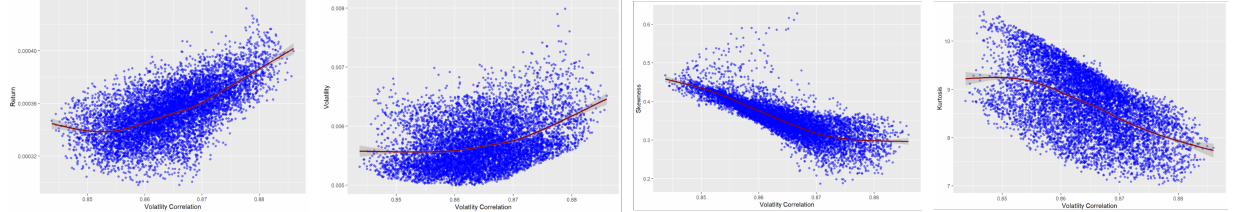
Figure 7. Relationship between mean, volatility, skewness, kurtosis, and volatility correlation of